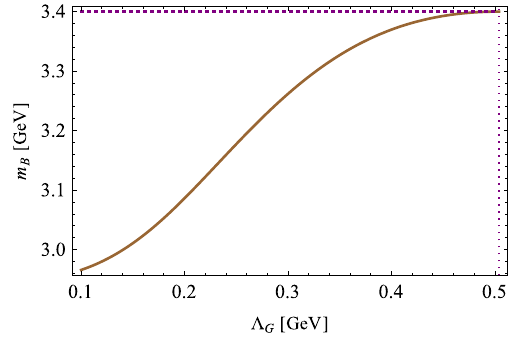
Fig. 3 Loop function (cid:11)( s ) of Eq. (27), real (orange, solid) and imagi- narypart(black,dash).Thesubtractionsarechosentomake (cid:11)( s ) vanish at s = m 2 and 3 m 2 . By construction, the imaginary part is nonzero G G above s > 4 m 2 G